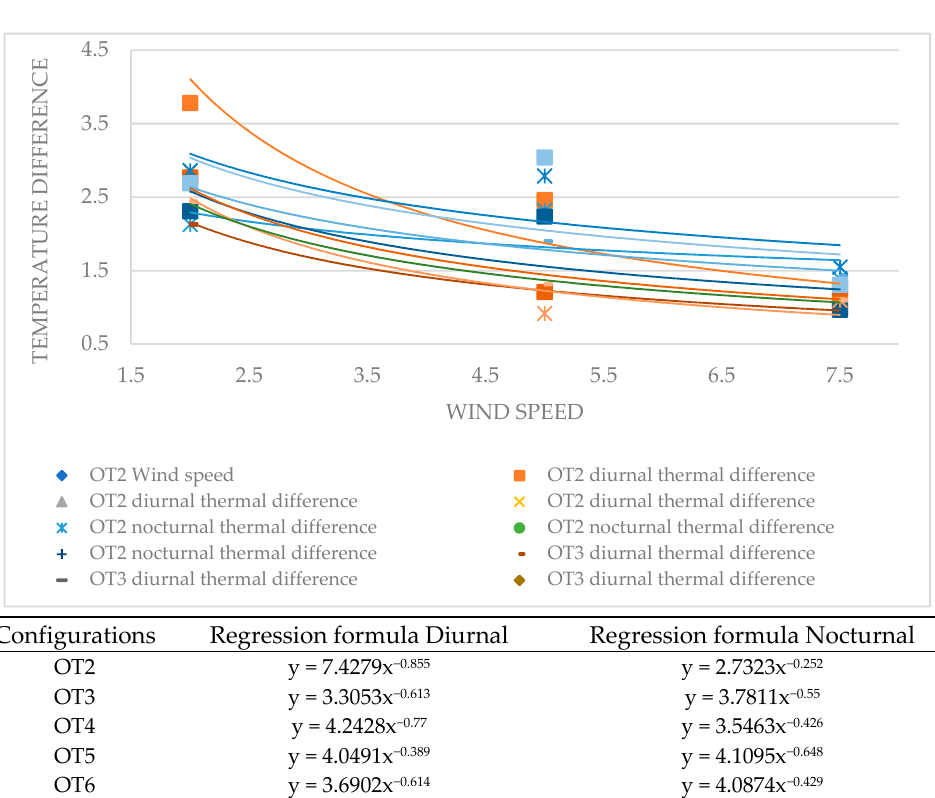
Figure 10. Correlation between the wind speed on the horizontal axis and maximum diurnal, nocturnal ambient air temperature difference on the vertical axis in Open Types configurations with their associated regression function formula.